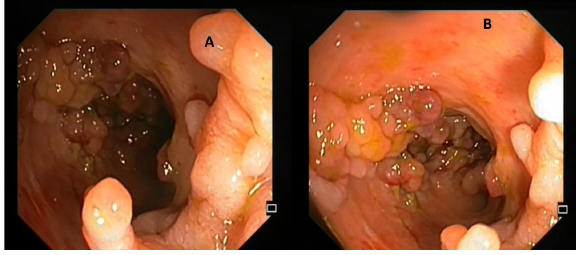
Figure 1. Endoscopic images showing multiple polyps in the sigmoid colon.